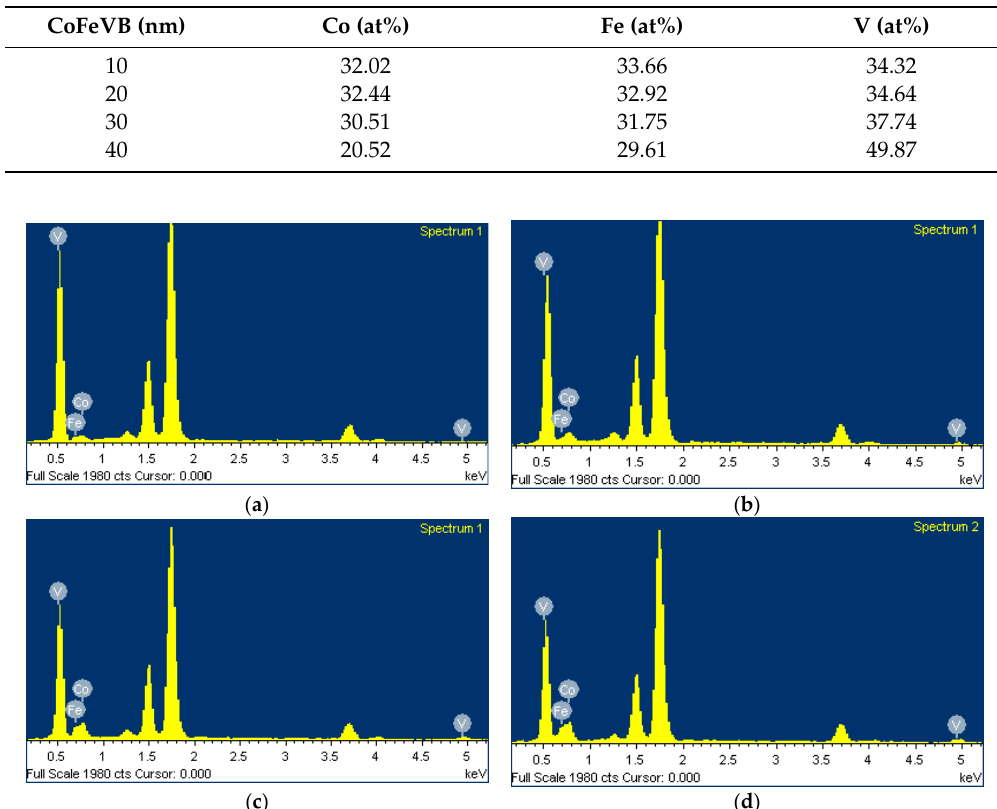
Figure 2. EDX patterns of the Co 40 Fe 40 V 10 B 10 thin films with various thicknesses. ( a ) 10 nm, ( b ) 20 nm, ( c ) 30 nm, and ( d ) 40 nm.